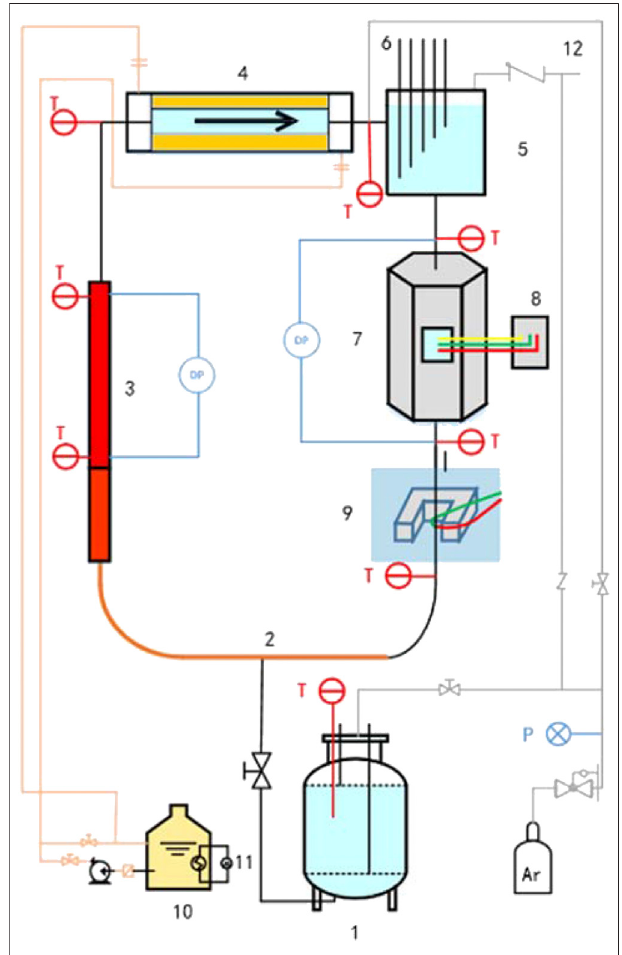
FIGURE1| SchematicoftheNCCLfacility,showing:1.LBEstorageand meltingtank;2.pre-heatingsection;3.testsection;4.heatexchanger;5.EMF calibration tube; 6. liquid-level probes; 7. EMP; 8. EMP control system; 9. EMF; 10. oil storage tank; 11. oil heating system; 12. gas